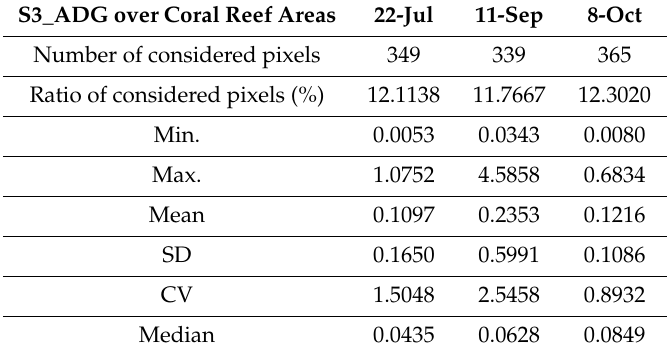
Table 2. Sentinel 3A Ocean and Land Colour Instrument (OLCI) data statistics for ADG443_NN product over (ROI) coral reef areas around Gu á nica to La Parguera Natural Reserve.